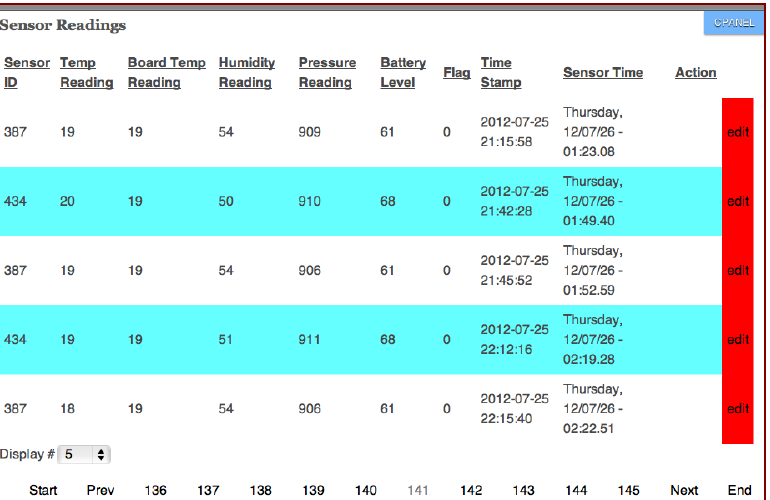
Figure 6. Wireless sensor network design.